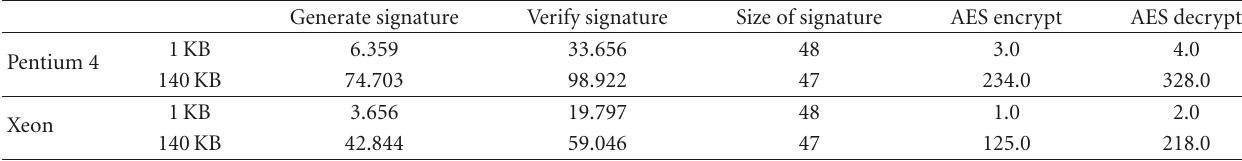
Table 5: Evaluation data of cryptography algorithms (Byte,